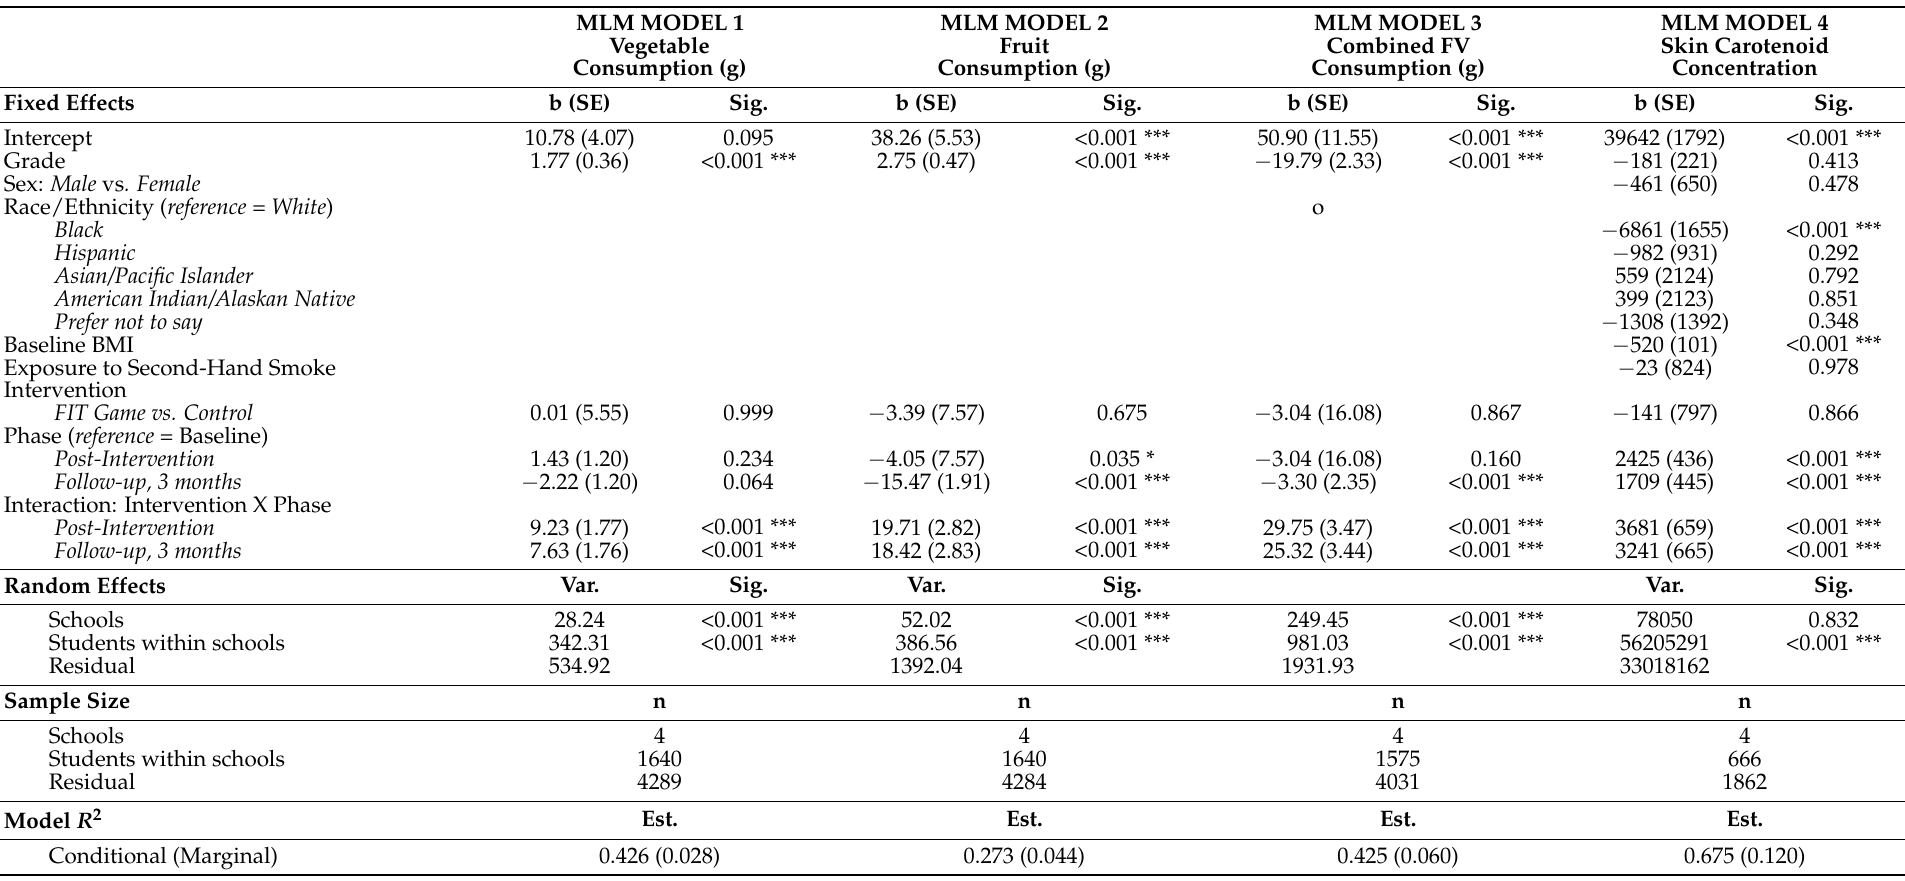
Table 2. Parameter estimates for four multilevel models (MLM), one for vegetable and fruit consumption (in grams) each separately, as well as combined (FV), and skin carotenoid counts investigating if the intervention moderated change across each phase of the